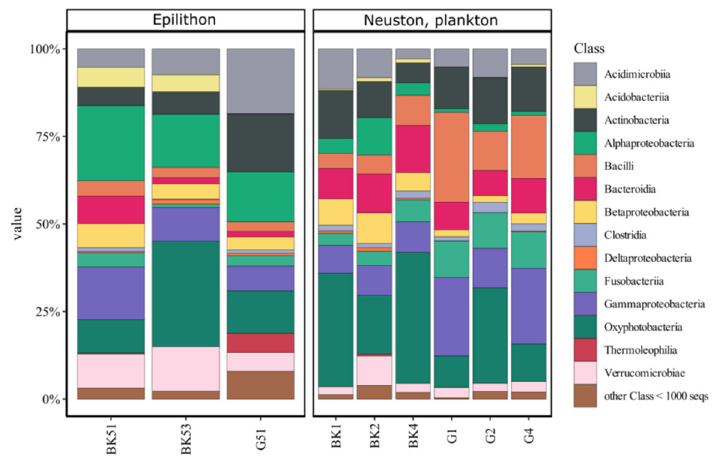
Figure 3. Taxonomic identification of 16S rRNA bacterial reads of epilithon (G51, BK51, BK53), neuston (BK1, G1), and plankton (BK2, BK4, G2, G4) of Lake Baikal at the class level.